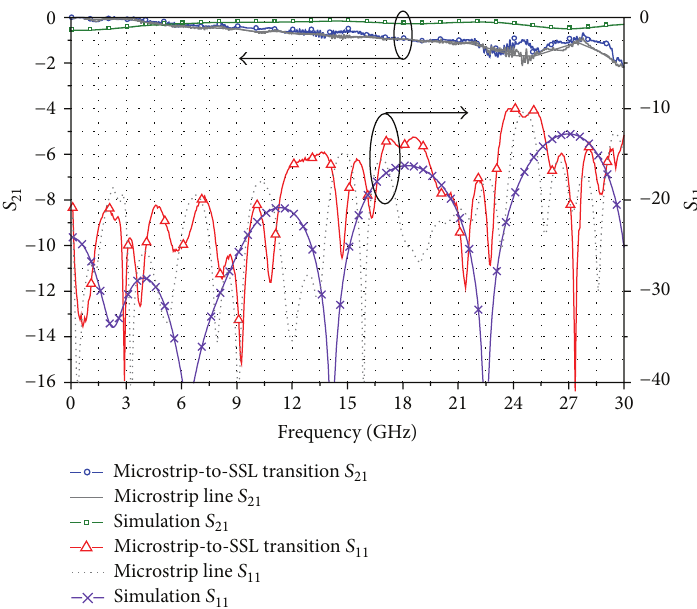
Figure 12: Simulated and measured insertion loss and return loss of the